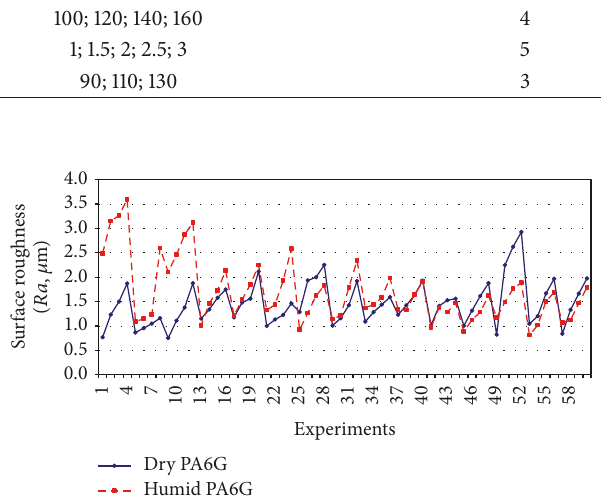
Figure 3: The change in surface roughness of humid and dry mate-